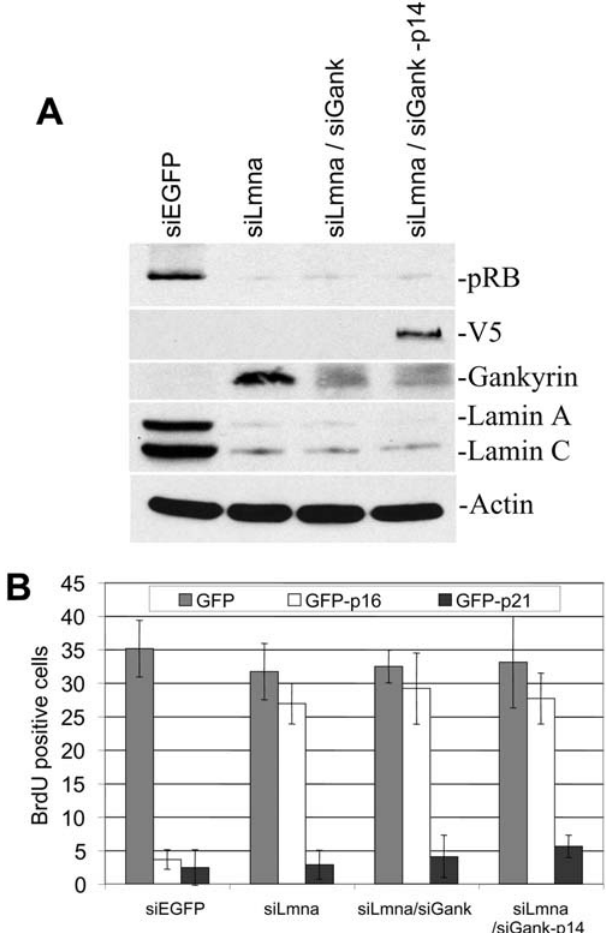
Figure 6. Expression of p14 arf in siLmna/siGank cells does not restore pRB levels or p16 ink4a sensitivity . NIH3T3 cells were infected with siRNAs targeted to Lmna and Gankyrin and then stably transduced with a V5 tagged p14 arf (siLmna/siGank-p14). (A) Western blot analysis comparing pRB levels in siEGFP cells, siLmna, siLmna/siGank, and siLmna/siGank-p14. (B) Cells were transfected with GFP-p16 ink4a or GFP-p21 cip1 and the S-phase cells were identified by BrdU incorpora- tion. The percentage of cells positive for GFP and BrdU incorporation were quantified.